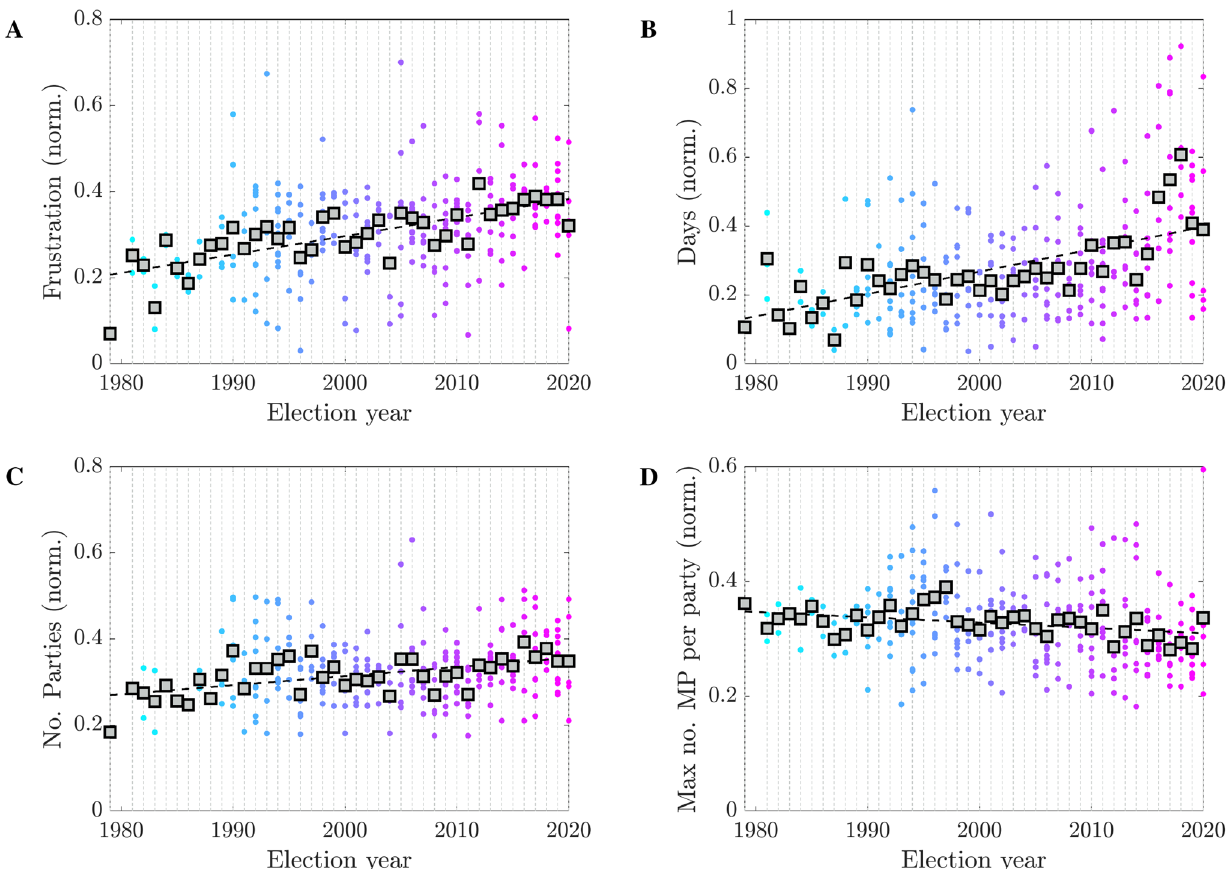
Figure 7. Yearly trends for the ensemble of 29 nations of Table 1 (normalized values). The gray boxes indicate the mean value for each year, the dashed black line the best linear fit for these mean values. ( A ) Frustration for scenario I ; ( B ) duration of the government negotiation talks (days); ( C ) number of parties in parliament; ( D ) maximum number of MPs per party in